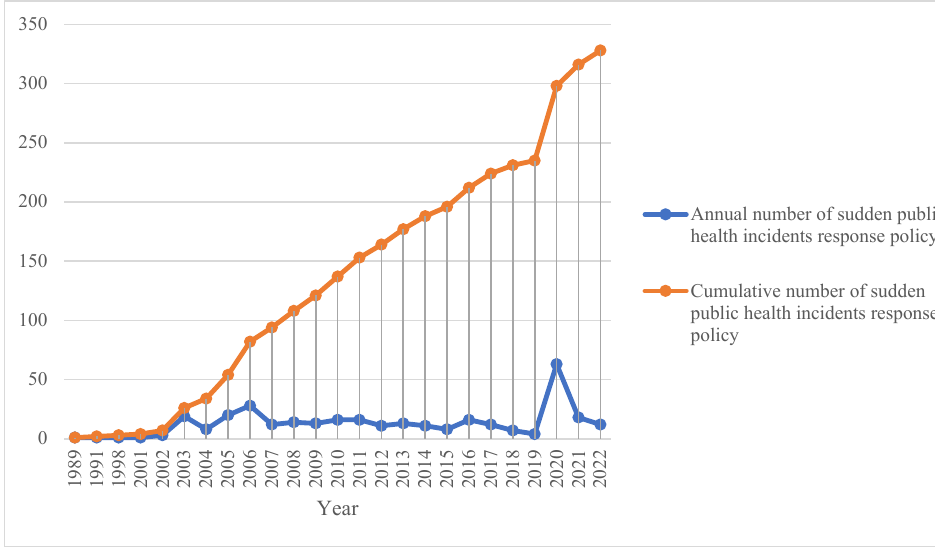
Figure 4. Annual and cumulative number of entrepreneurship policy.